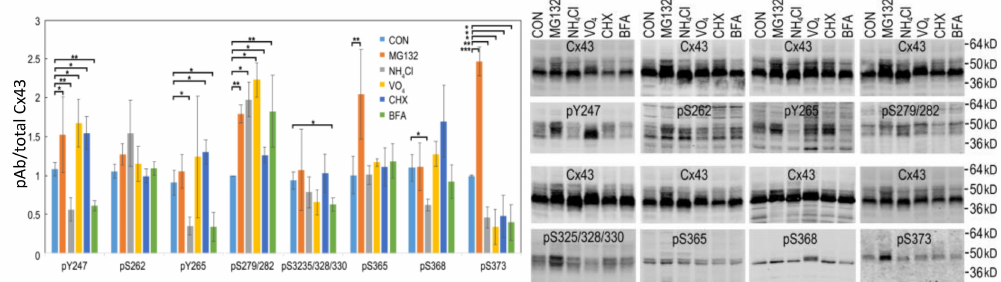
Figure 5. LA25 cells were treated with 10 µ M MG132, 25 mM NH 4 Cl, 500 µ M sodium orthovanadate (Na 3 VO 4 ), 25 µ g / mL cycloheximide (CHX), or 5 µ g / mL Brefeldin A (BFA) for 2 h and immunoblotted for total Cx43 (Cx43) and phosphospecific antibodies for Y247, S262, Y265, S279 / 282, S325 / 328 / 330, S365, S368, and S373. Phospho-antibody signal was normalized to total Cx43 and quantified in graph. Representative immunoblots are shown. *, ** and *** indicate p < 0.05, p < 0.01 and p < 0.001,